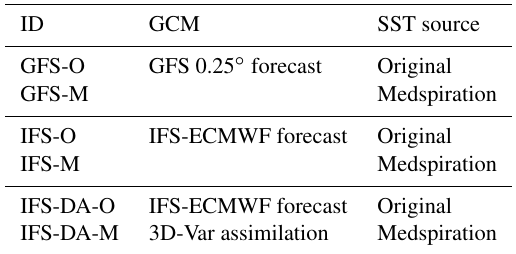
Table 2. List of simulations and their related